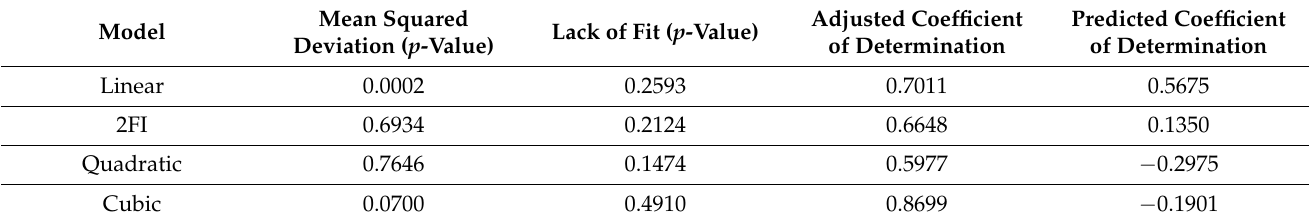
Table 8. Simulation of four models in the design expert insufficient/excessive throat thickness.